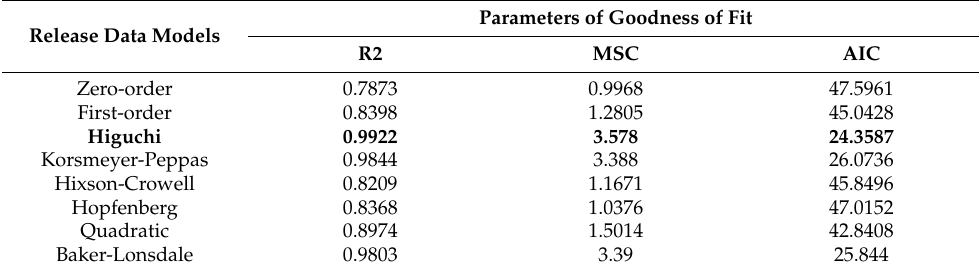
Table 1. DDSolver release data kinetic models to assess the release behavior of MXT from MLG for-